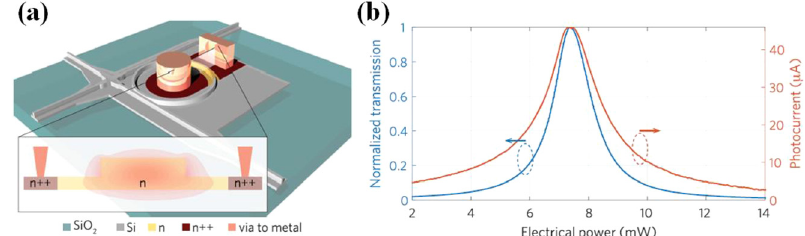
Figure 18: (a) Schematics of the cascaded microring filter; (b) transmission spectrum of the cascaded microring fi lter; (c) transmission spectrum of the cascaded microring under different applied power; [218].